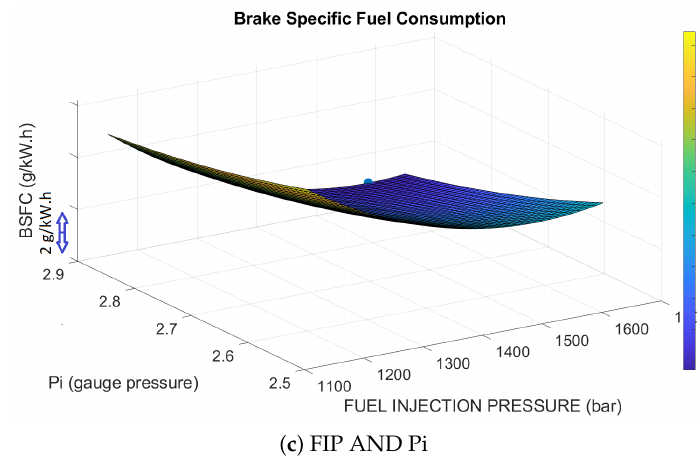
Figure 8. Response surface of the BSFC at one operating point.